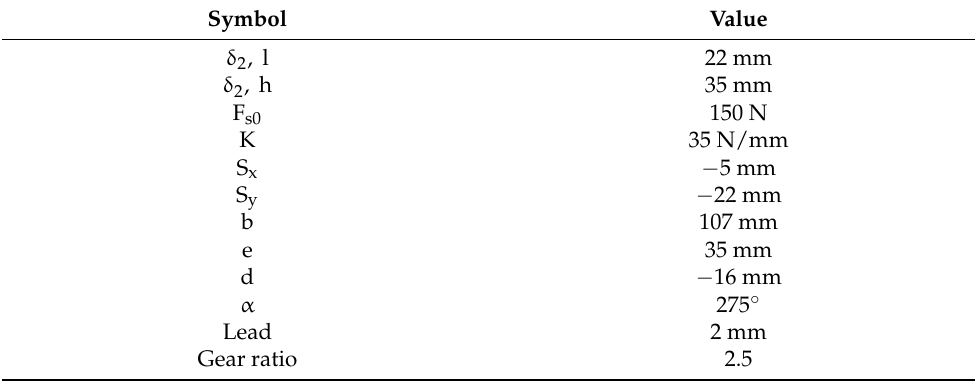
Table 1. Parameters for Linear Implementation.